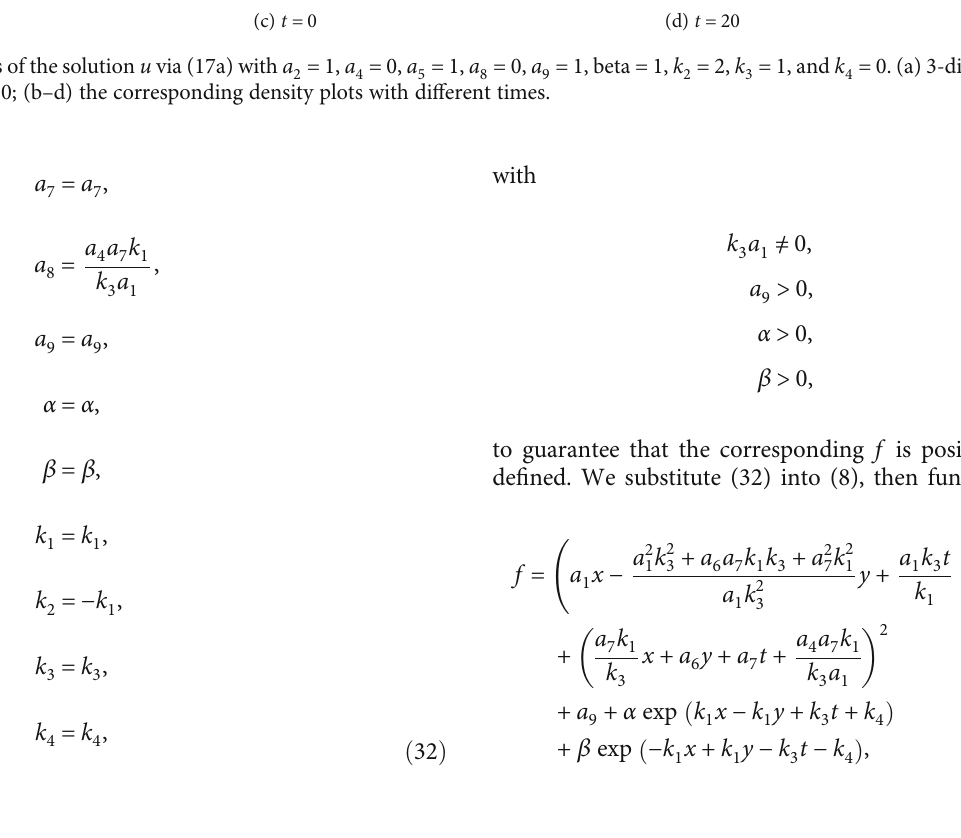
= 1 , a = 0 , a = 1 , a = 0 , a = 1 , beta = 1 , k 2 4 5 8 9